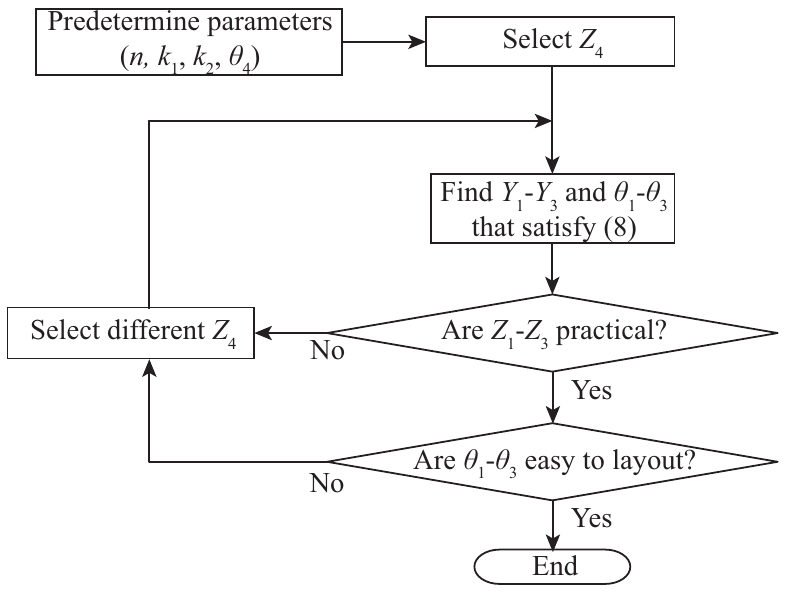
Figure 4. Design flow chart for proposed coupler. Table 1. Design parameters of proposed branch-line